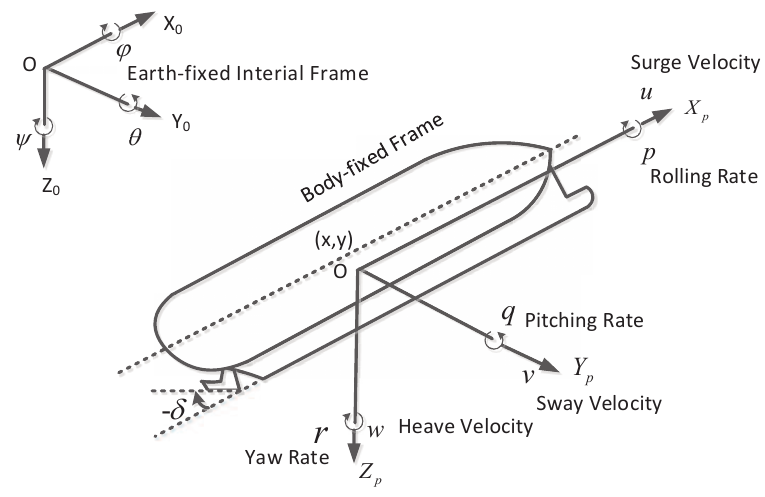
Figure 1. The Earth-fixed inertial and the body-fixed